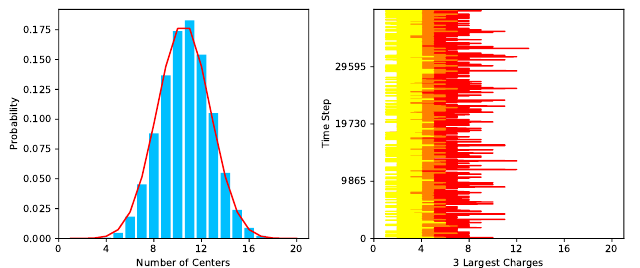
Figure 14: A sample random walk done in model 2. On the left of each plot is the random walk probability to have a particular number of centers, with the fractional number of microstates with a particular number of centers plotted in red. On the right is a plot of the three largest charges present at each step in the random walk, shown in red, orange, and